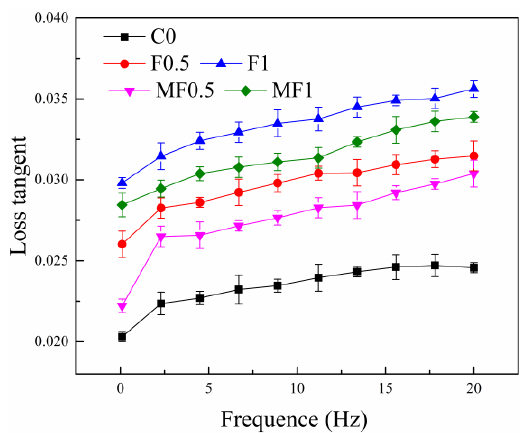
Figure 9. Loss tangent of the cement specimens for different frequencies.